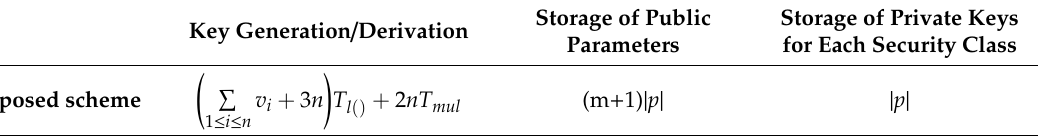
Table 8. Analysis of computation complexity.